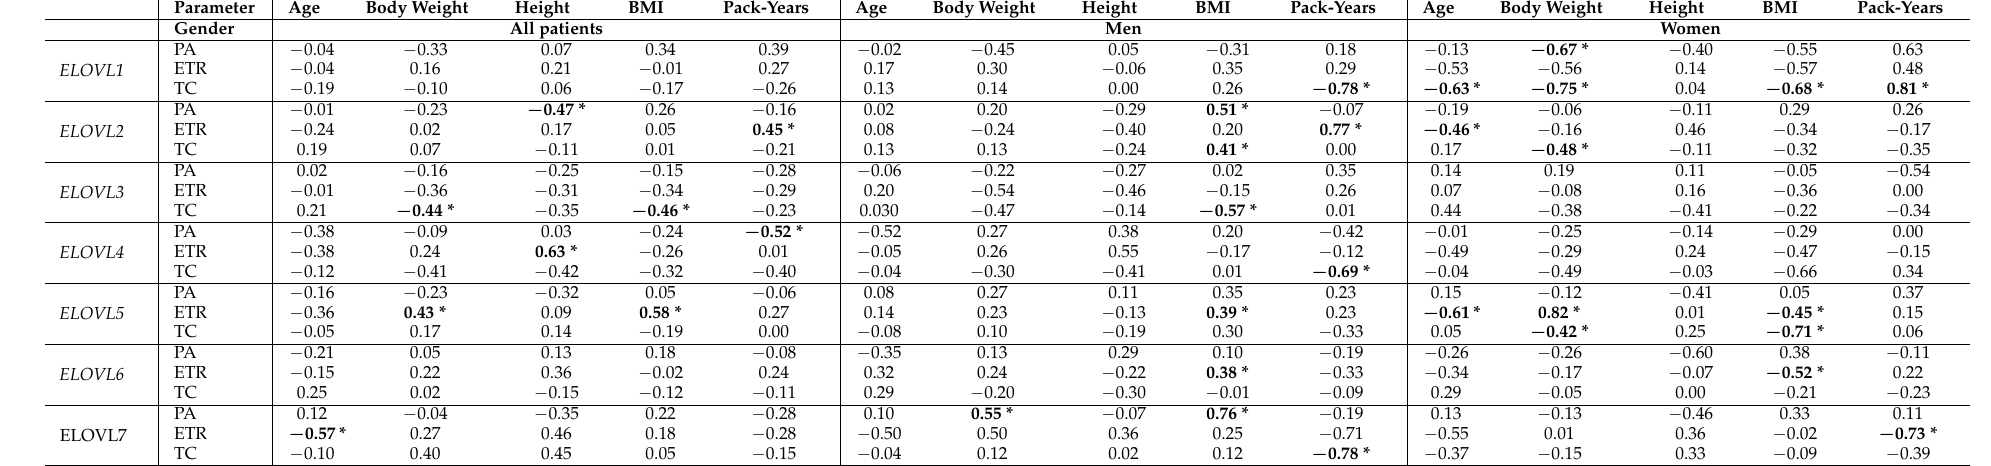
Table 5. Correlation between the expression of the elongases studied and the characteristics of